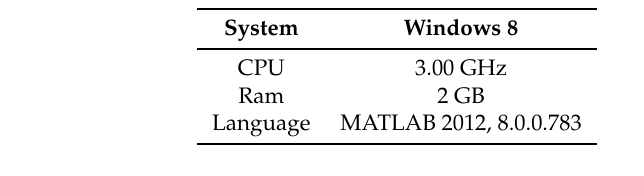
Table 2. Parameters’